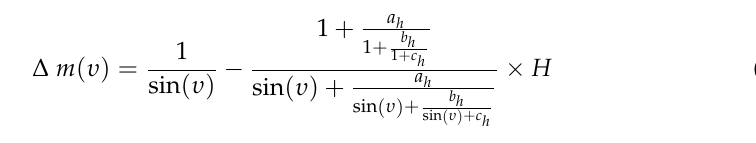
CSRS vs. FKP, CSRS vs. NEA, RTKLIB vs. VRS, RTKLIB vs. FKP, RTKLIB vs. NEA, Static vs. VRS; Static vs. FKP and finally Static vs. NEA.